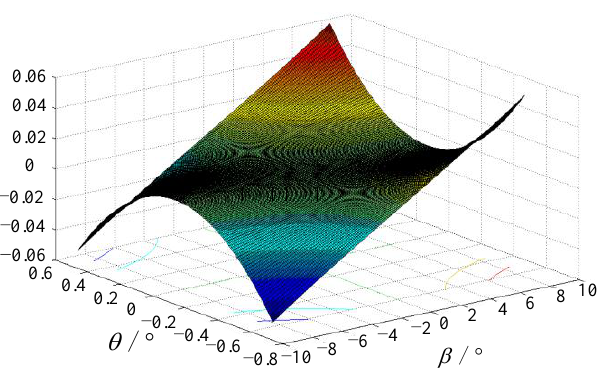
P | − | P P |)/pixel. Ti + Ti− Ii + Ii−